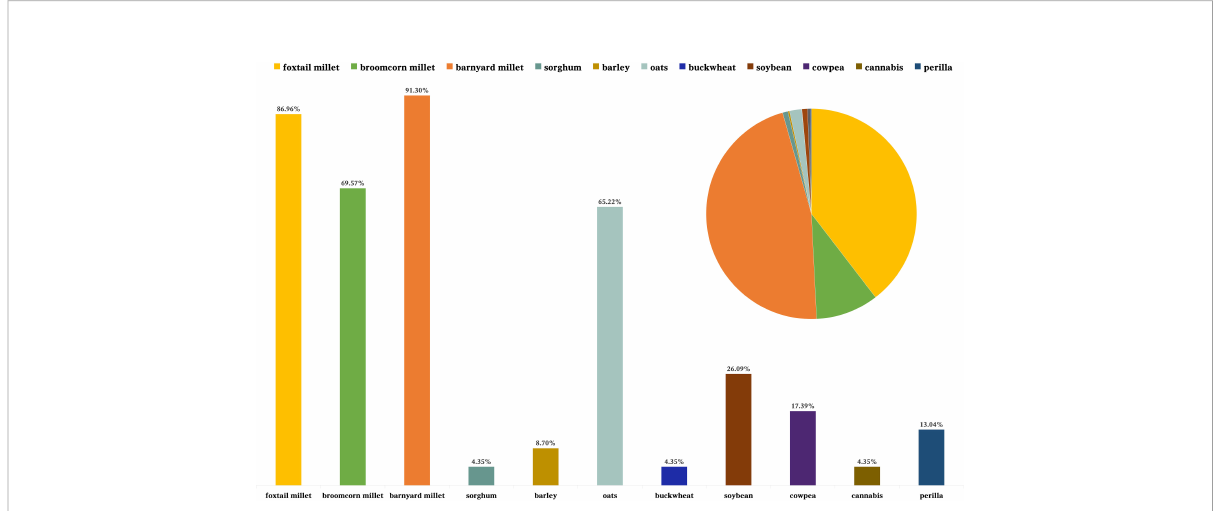
FIGURE 2 Statistical chart of the absolute number and ubiquity of agricultural crops at the LMC site.